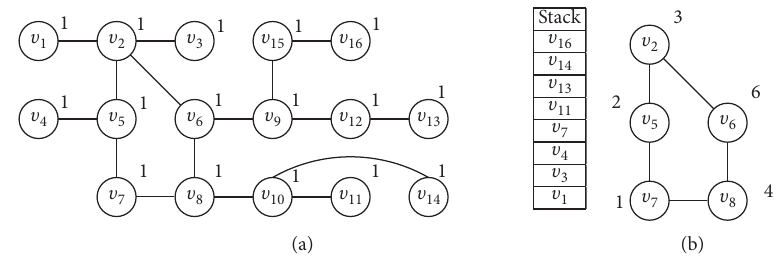
Figure 2: A unicyclic graph having the Wiener index